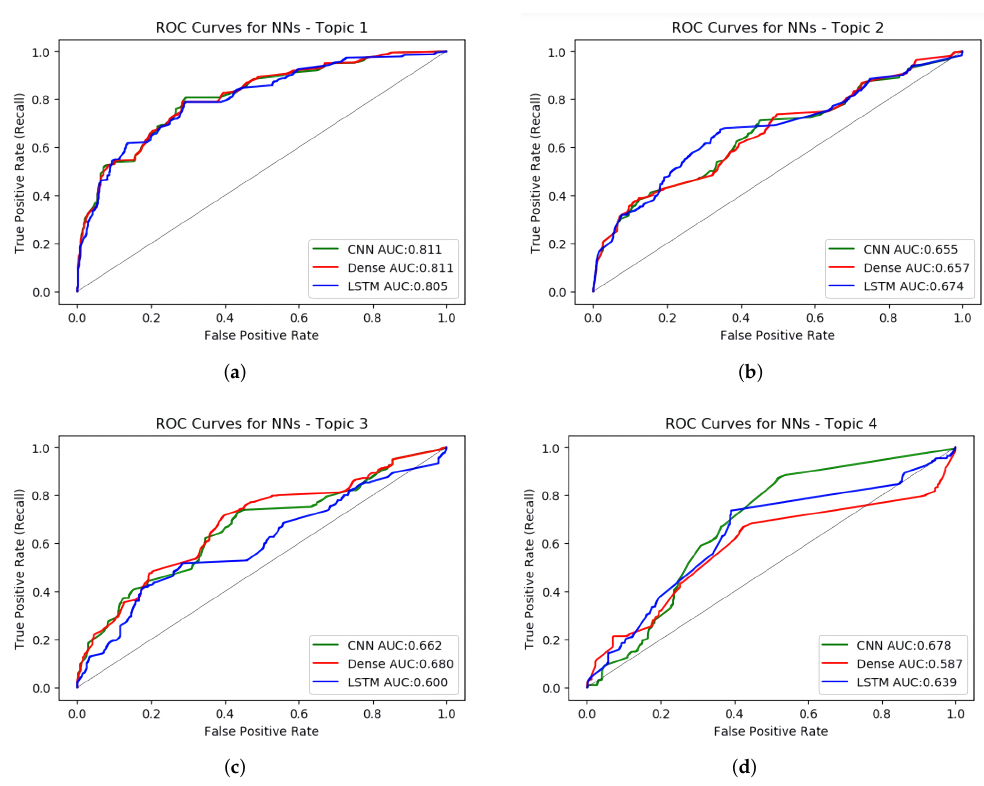
Figure 7. ROC curves of different neural networks algorithm’s for the data sets related to the dominant topics. ( a )Topic 1. ( b ) Topic 2. ( c ) Topic 3. ( d ) Topic